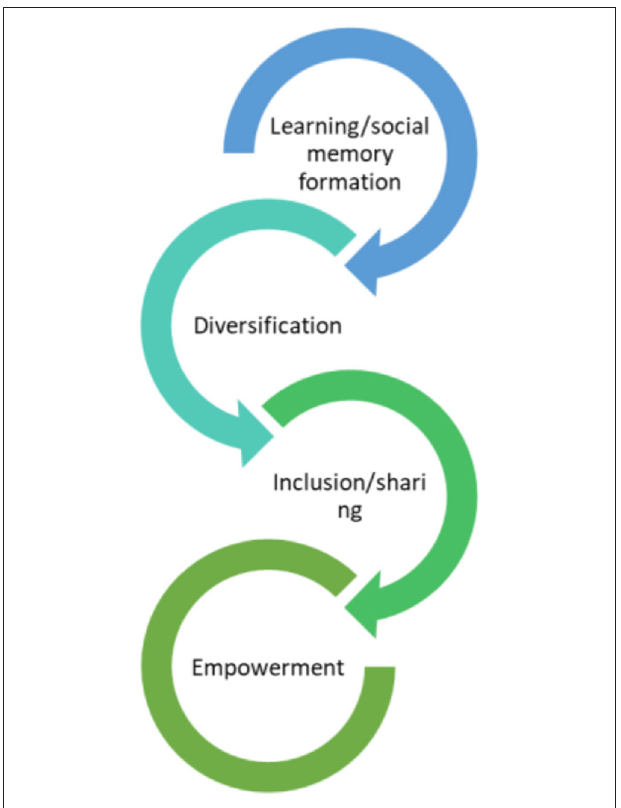
FIGURE 3 | Dynamics between elements −